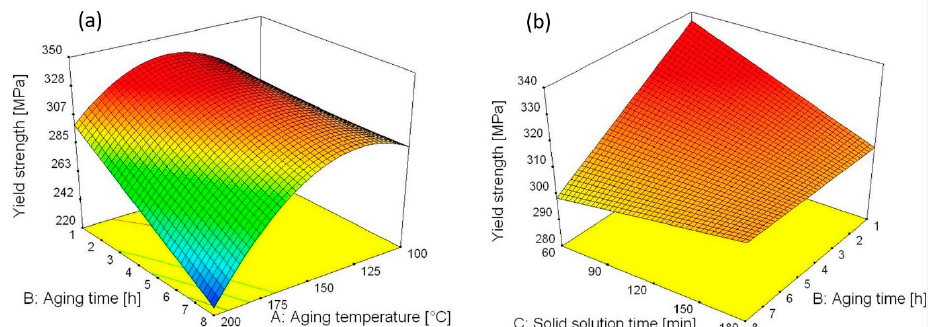
Figure 6. ( a ) Influence of aging temperature and aging time on yield strength of SSR samples for constant solid solution time at 60 minutes ( b ) Influence of solid solution time and aging time on yield strength of SSR samples for constant aging temperature at 150 °C.